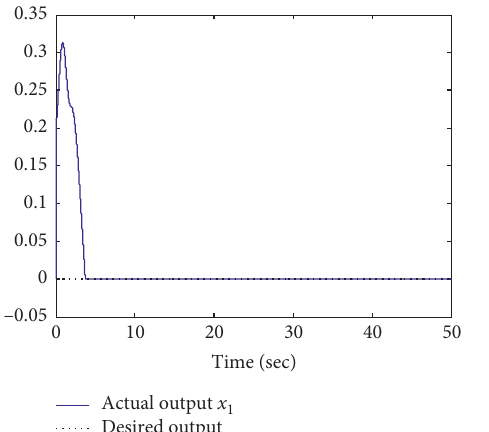
for our controller. 2